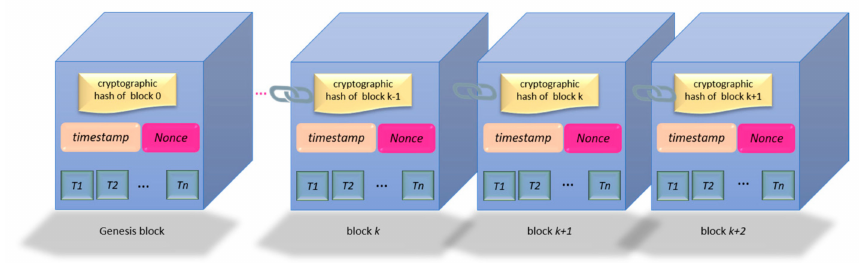
Figure 1. Blockchain architecture.